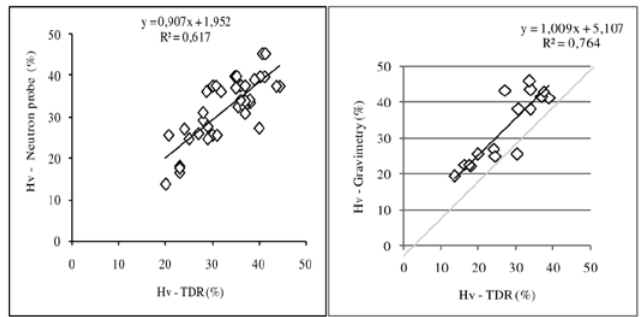
) were v , where N and N Fig. 4 - Relationships between H (%) measurements made simultanu- water water v ously with TDR, neutron probe and